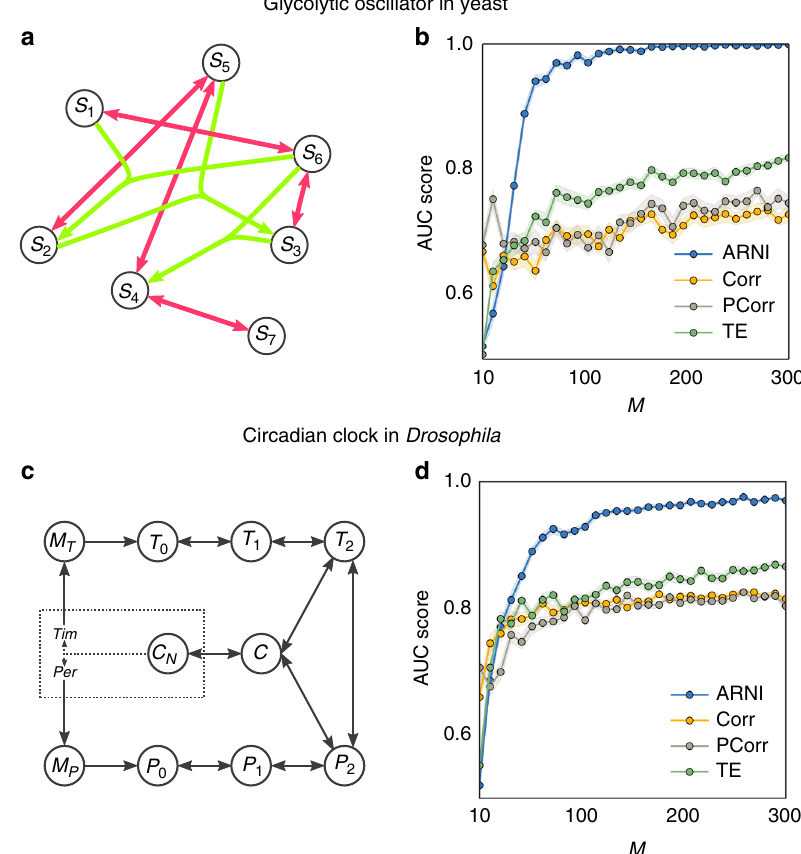
Fig. 7 Reconstructing biological model systems. a – c Revealing interactions of glycolytic oscillator in yeast. a Glycolytic oscillator network, red and green links represent network and hypernetwork interactions, respectively. b Quality of reconstruction from transient trajectories as a function of M = S × m with m = 10. c Circadian clock network in Drosophila . d Quality of reconstruction as in